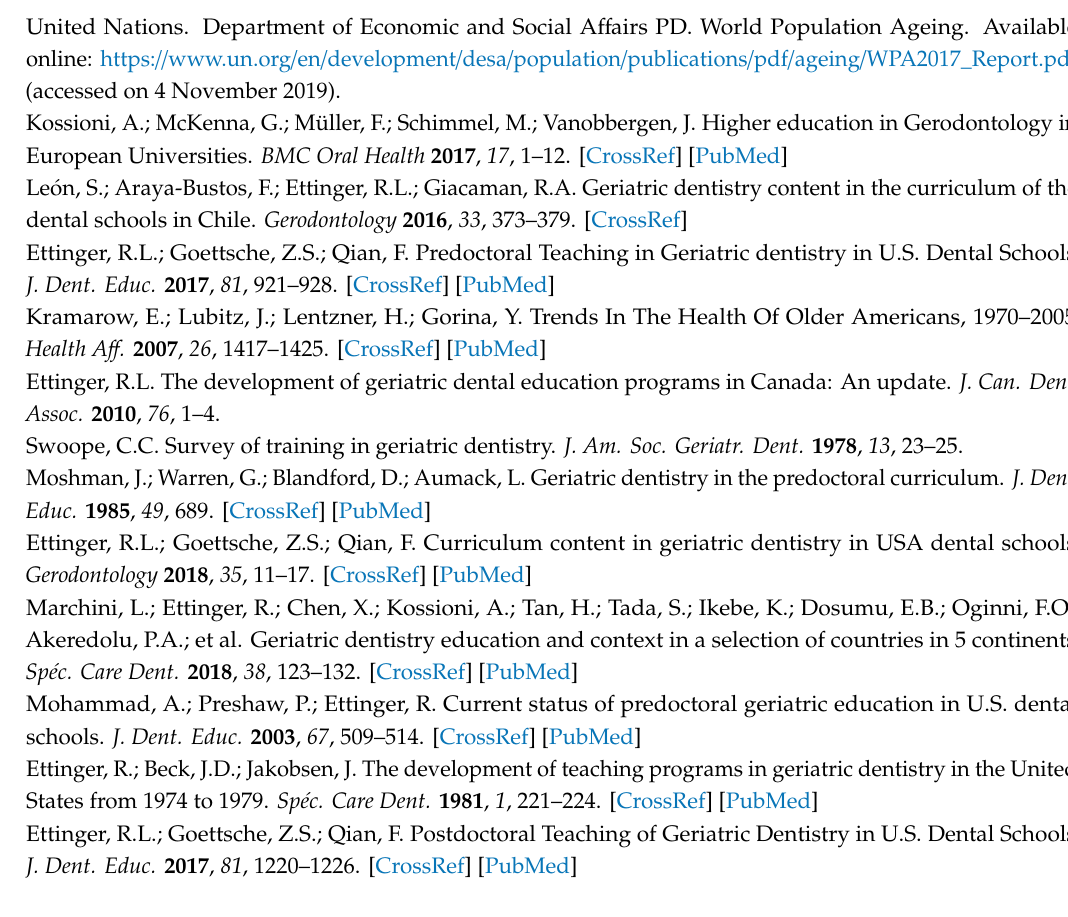
Table S1: Curriculum content in geriatric dentistry in Dental Schools questionnaire; Table S2: Inclusion of geriatric dentistry teaching into curriculum over time, expressed as a percentage from total responses; Table S3: Comparison of dedicated gerodontology teaching formats in over 40 years, expressed as a percentage from total responses; Table S4: Topics covered by lectures and seminars: (A) traditional topics (oral medicine / prosthodontics) and (B) non-traditional topics (gerontologic), expressed as a percentage from total responses; Table S5: Funding of geriatric undergraduate programs, expressed as a percentage from total responses; Table S6: Remote sites of clinical geriatric care, expressed as a percentage from total responses; Table S7: Department responsible for teaching didactic and clinical geriatric dentistry, expressed as a percentage from total